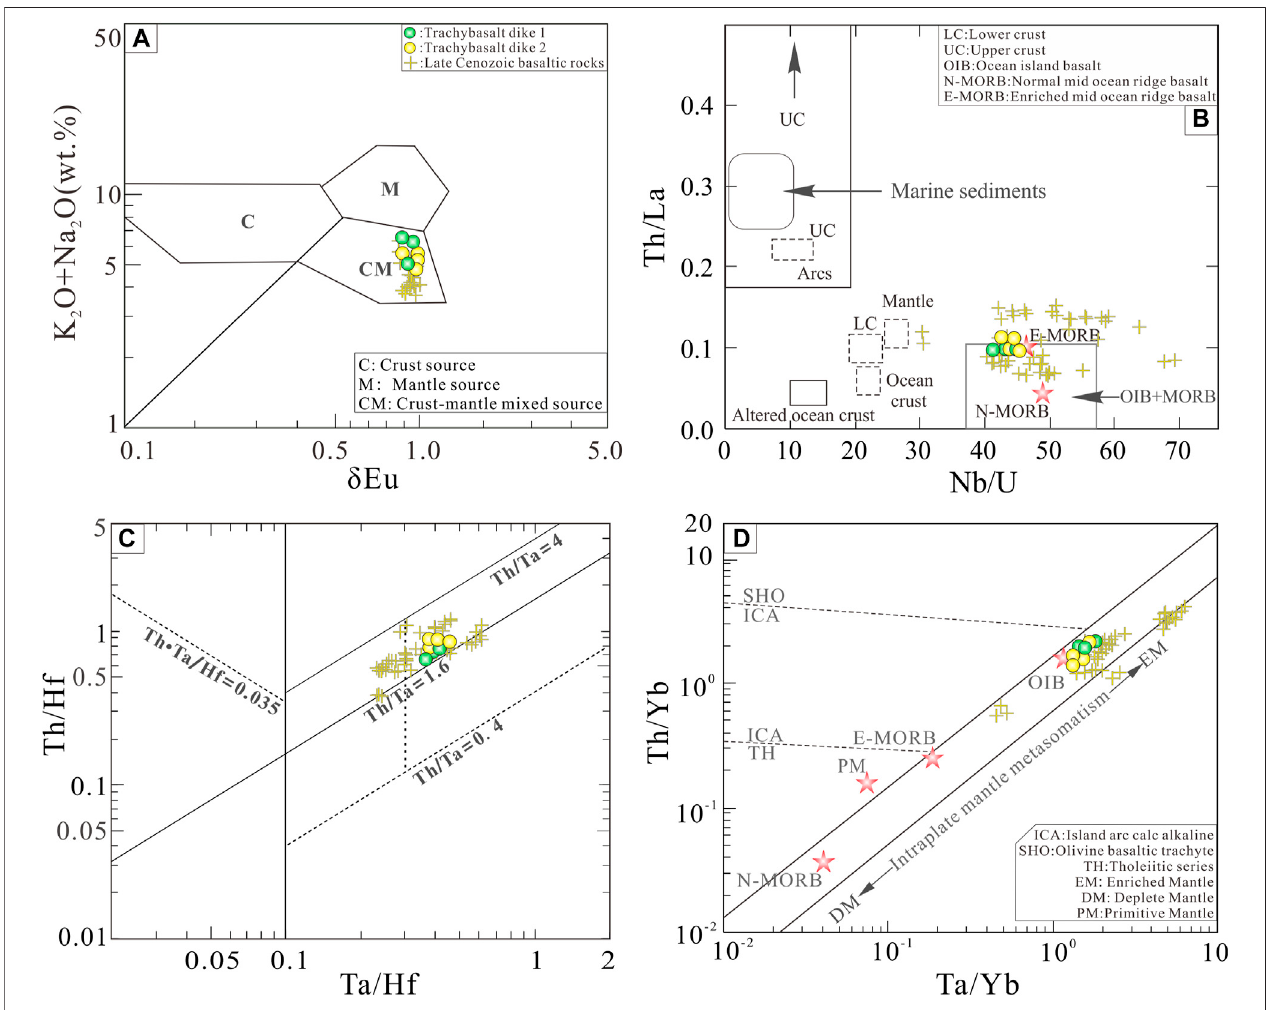
FIGURE10|(A) K 2 O+Na 2 Ovs. δ Eu, (B) Th/Lavs.Nb/U, (C) Th/Hfvs.Ta/Hf,and (D) Th/Ybvs.Ta/Ybdiagrams(Li,1992;Deng,2004;Zhao,2016),showingthat the eastern Jilin Province basaltic rocks (early Pleistocene, including the Changbai Mountain trachybasaltic dikes) mainly plot in the intraplate fi eld. Data of the trachybasalt dikes are from this study, and other data sources are as for Figure 7 .